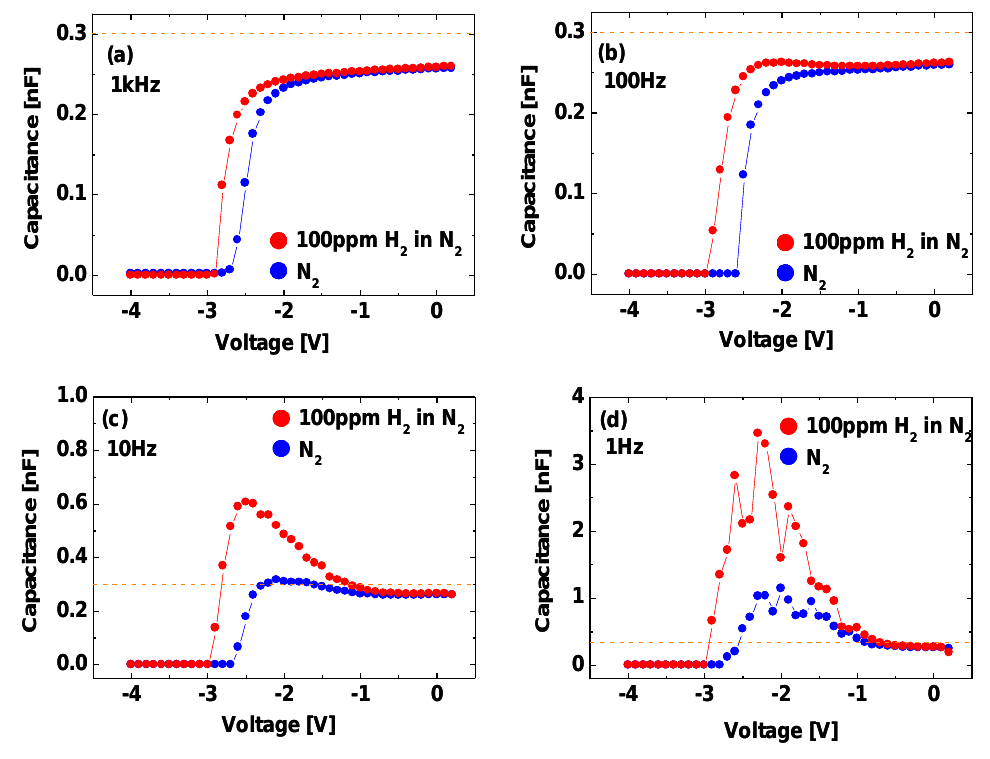
Figure 14. C-V characteristics at 1 kHz (a) , 100 Hz (b) , 10 Hz (c) and 1 Hz (d) of the Pt–AlGaN/GaN SBD in N temperature.